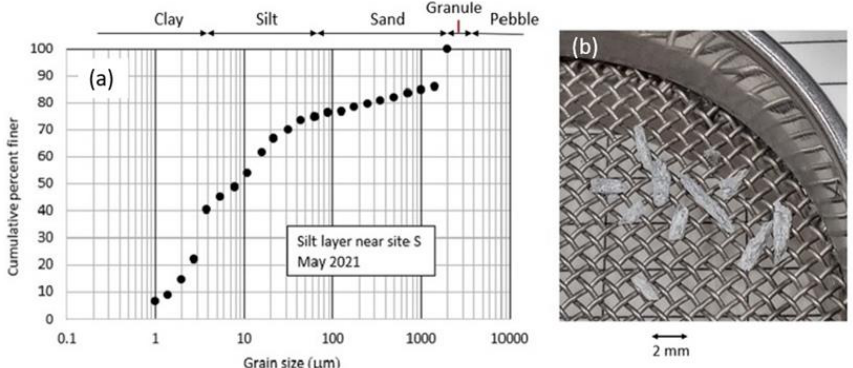
Figure 7. ( a ) Grain size distribution for a silty layer and ( b ) gypsum crystals, contained in the silty layer, on a stainless sieve.